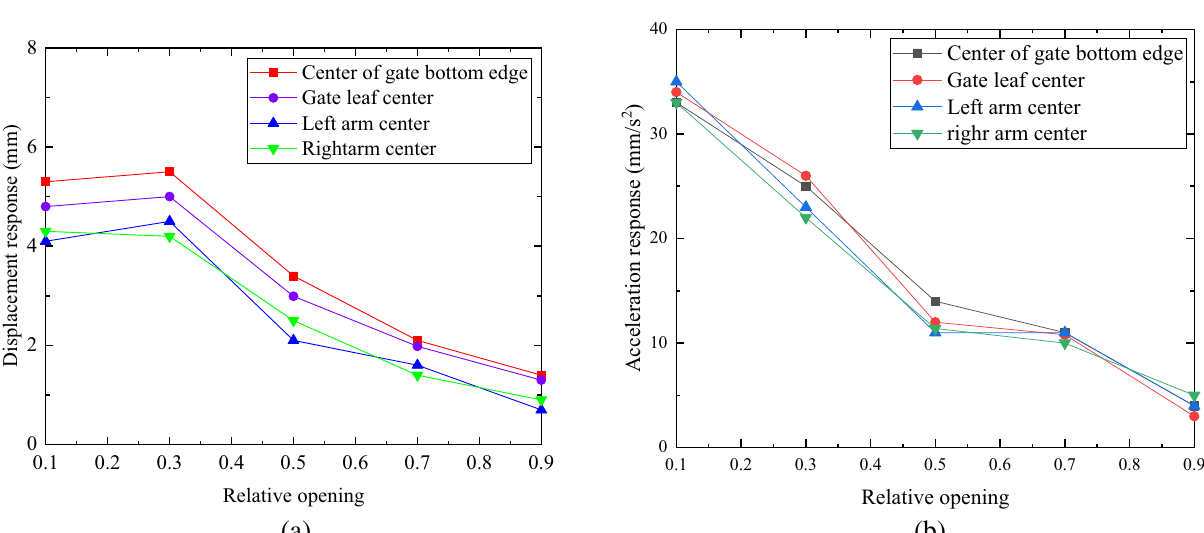
Figure 12. Variation curve of maximum response of gate with relative opening. ( a ) Peak value of displacement response with different opening, and ( b ) Peak value of acceleration response with different